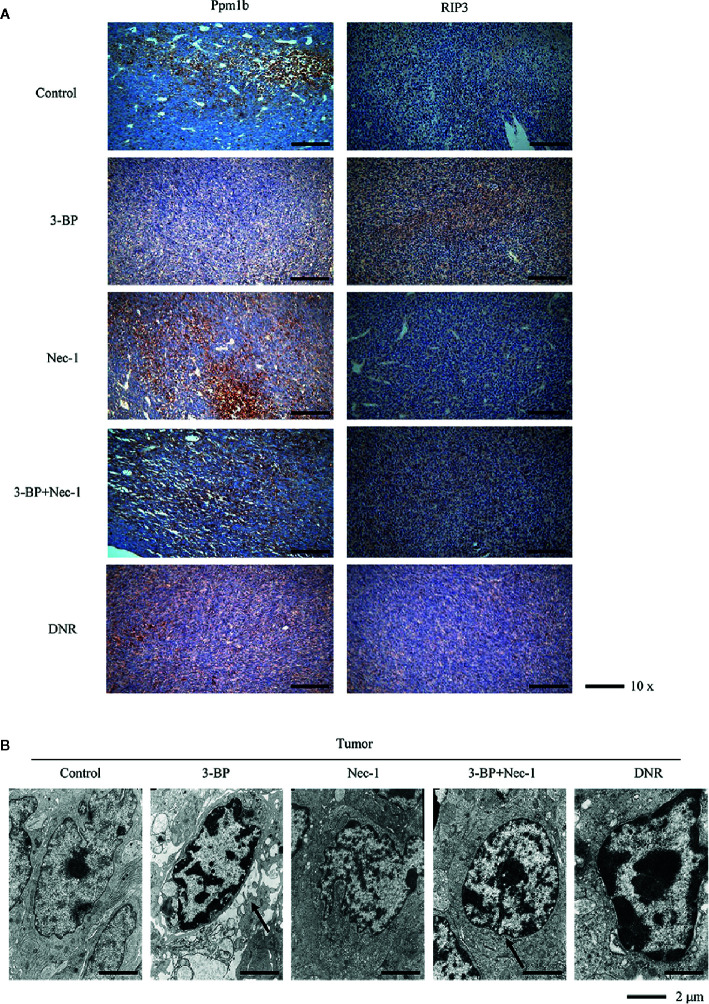
Necroptosis induced by 3BP in vivo. (A) Expression of Ppm1b and RIP3 in tumor tissue were detected by immunohistochemistry. then visualized under a fluorescence microscope. (B) Mice were treated 3-BP for 24 h, and necroptosis in tumor tissue were detected by Electron Microscopy analysis.